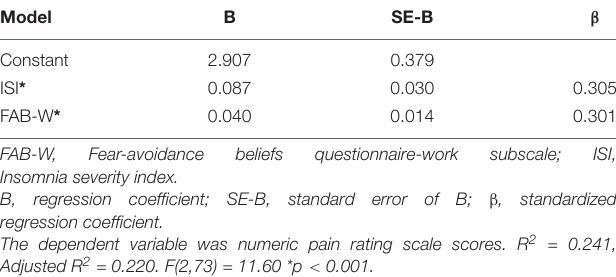
TABLE 5 | Summary of stepwise regression model predicting numeric pain rating scale scores.